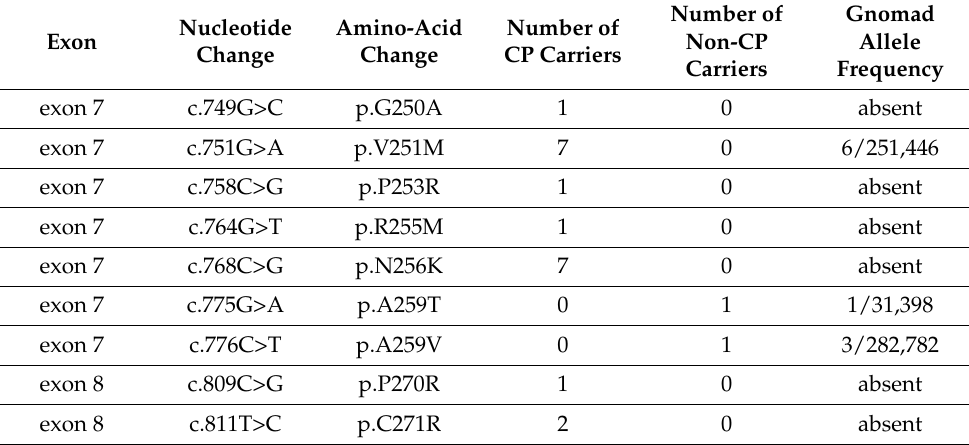
Table 1. Natural CPA1 variants in the disulfide-stabilized loop sequence published to date. CP, chronic pancreatitis. Note that variant p.A259V was not included in this study.